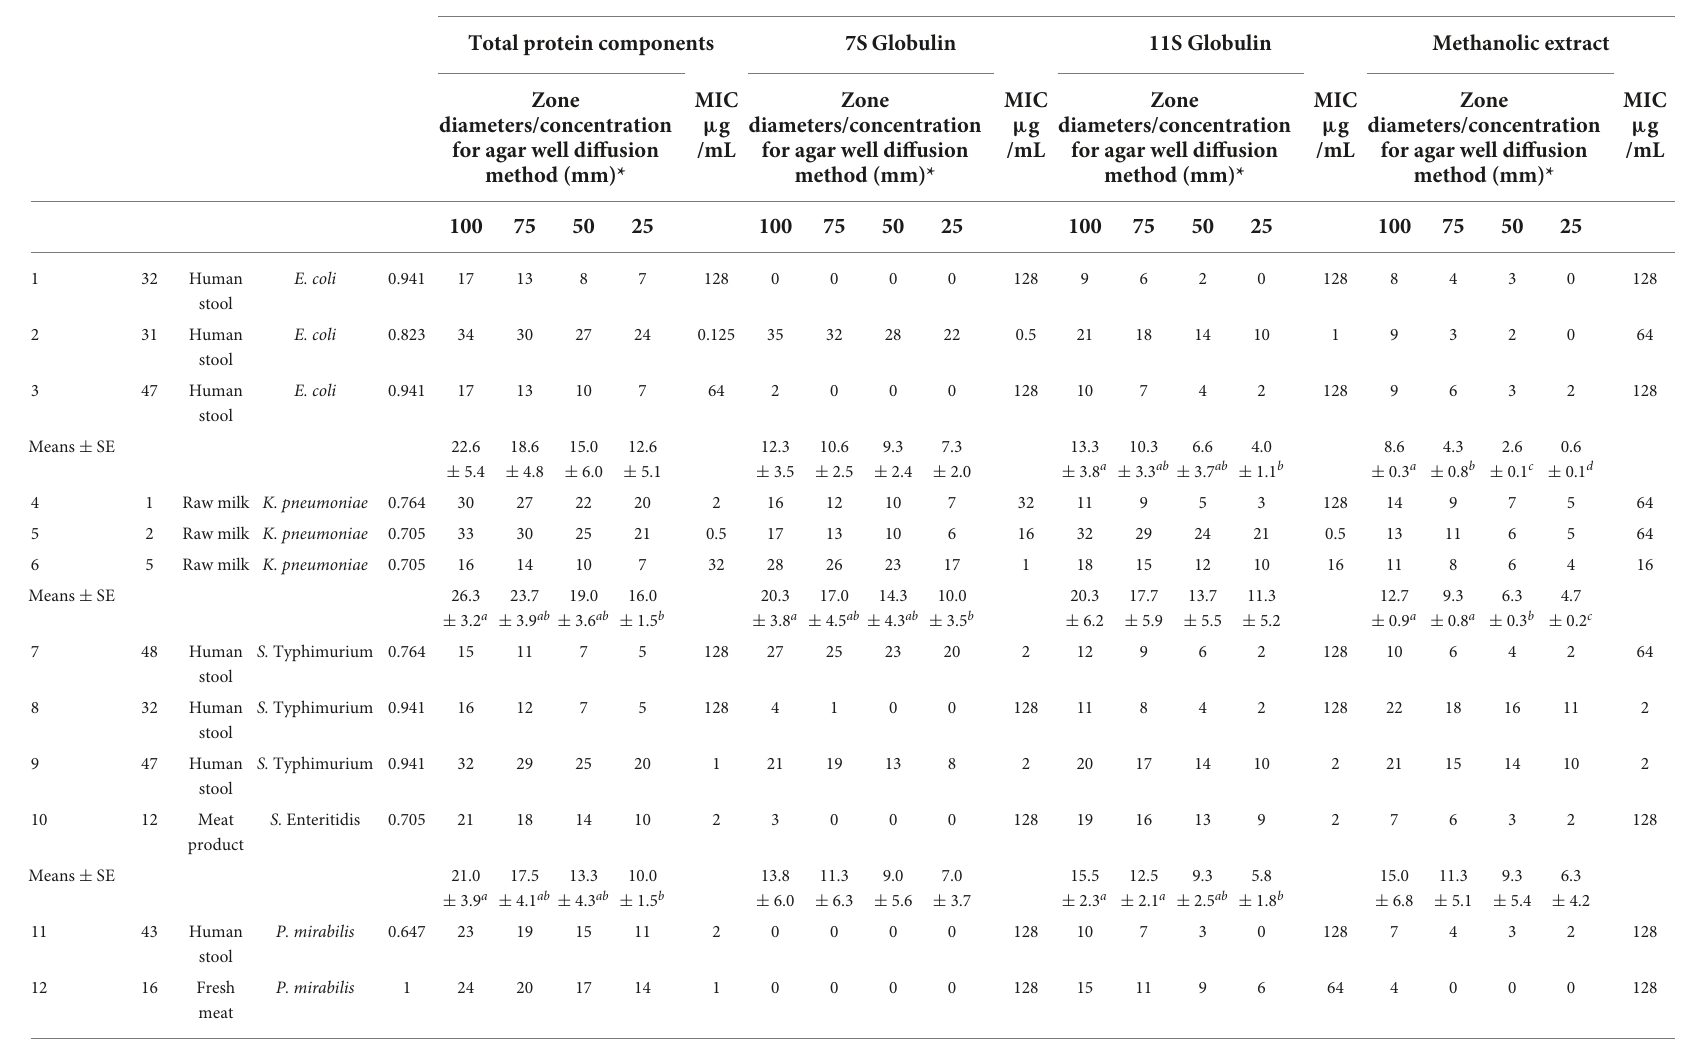
TABLE 6 Antimicrobial activities of Phaseolus vulgaris extracts against Enterobacterales isolates. Isolate